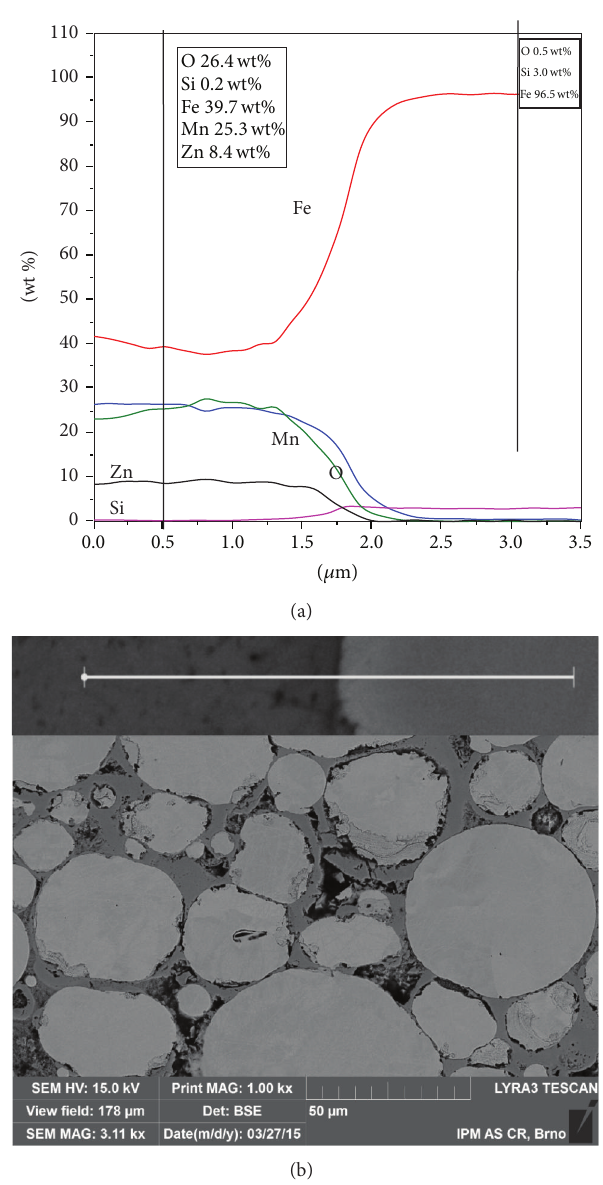
Figure 9: EDX line analysis of the final sintered sample FeSi/ Mn 0.8 Zn 0.2 Fe 2 O 4 supplementedwithtwochartsinvolvingthechem- ical composition at the distances 0.5 𝜇 m and 3 𝜇 m according to the scale of zoom located on the